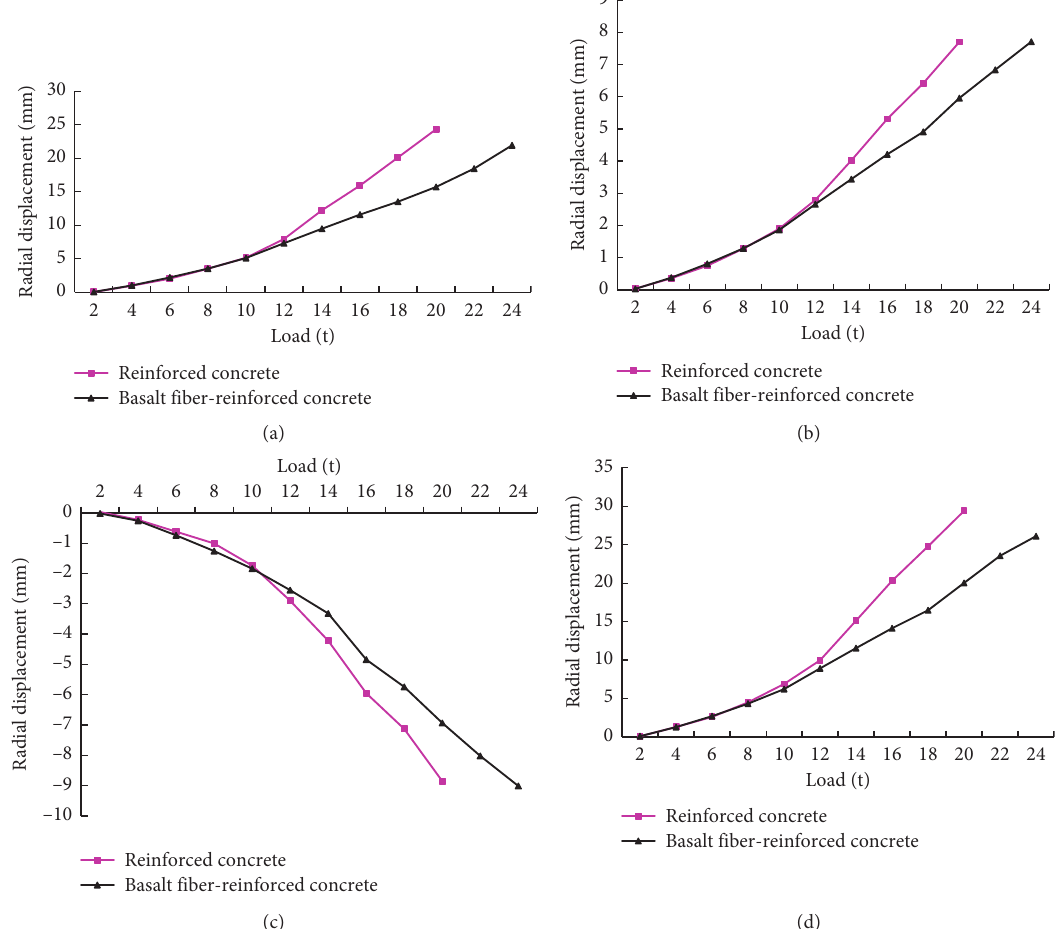
Figure 13: Change curve of the radial displacement and load. (a) Measuring point 1-vault, (b) measuring point 2-haunch, (c) measuring point 3-middle of side wall, and (d) measuring point 4-middle of inverted arch.